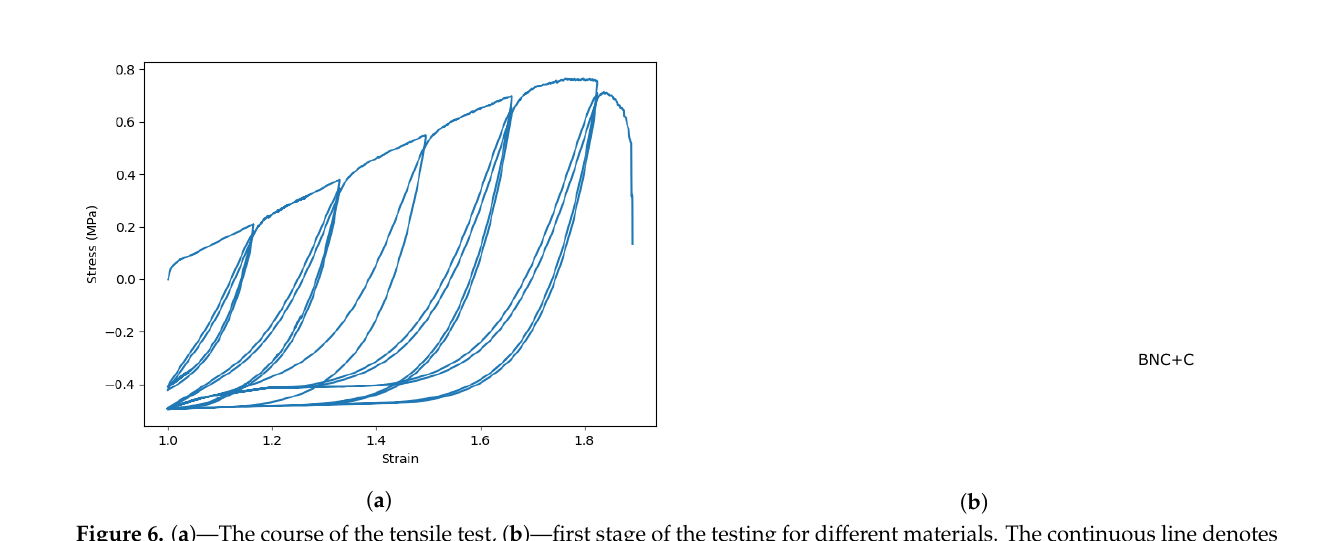
Figure 6. ( a )—The course of the tensile test, ( b )—first stage of the testing for different materials. The continuous line denotes the crosshead strain, and the dotted line denotes the video extensometer strain.